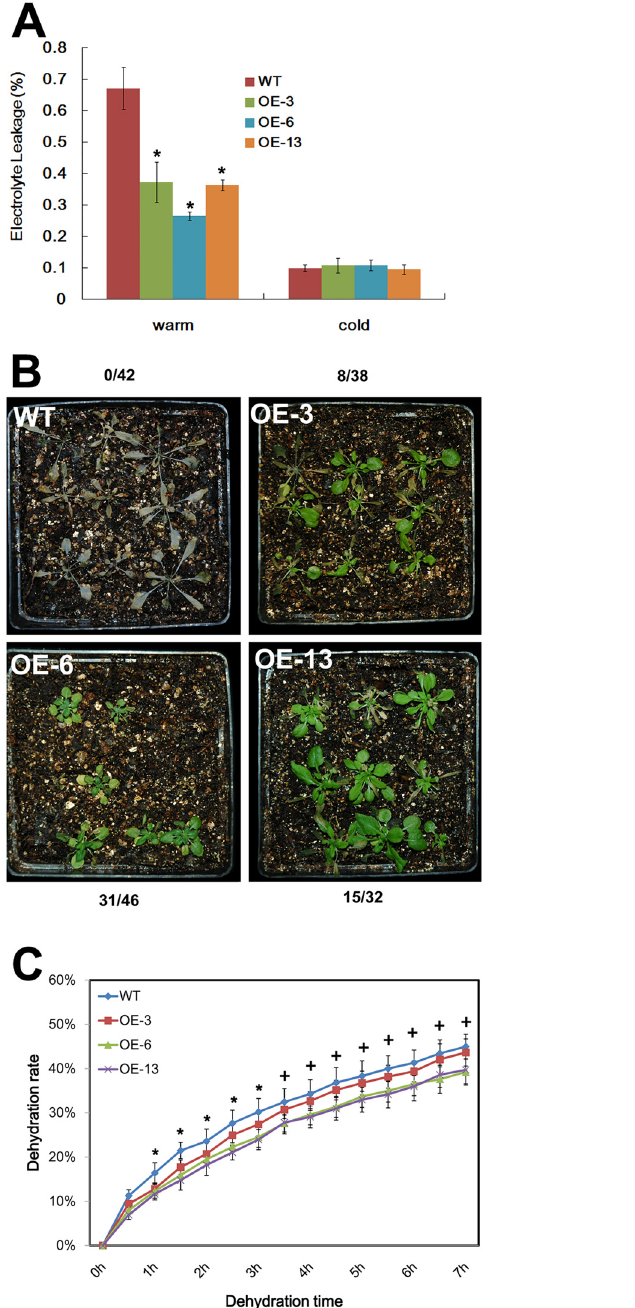
Fig 5. HbCBF1 overexpression conferred cold resistance and relatively slow dehydration in Arabidopsis . (A) The electrolyte leakage rates of col-0 , OE-3, OE-6 and OE-13 lines under nonacclimated (warm) or 5-days cold — acclimated conditions (cold). Electrolyte leakage was measured using leaves from two-week-old seedlings frozen to -7°C at a refrigerating rate of 1°C per h from -1°C. The star symbol ( * ) indicates significant difference between each individual OE line and wild type plants (WT). (B) Representative seedlings of col-0 , OE-3, OE-6 and OE-13 lines recovered from 18 hours frozen at -6°C. The survival rates of each line were listed. (C) The dehydration rates of the detached leaves from col-0 , OE-3, OE-6 and OE-13 seedlings. The star ( * ) symbol indicates significant difference between WT and each individual OE line, while plus symbols (+) shows significant difference between WT and individual OE-6 and OE-13 line. Data in A and C were presented as mean ± standard error of mean of five biological replicates. Significance